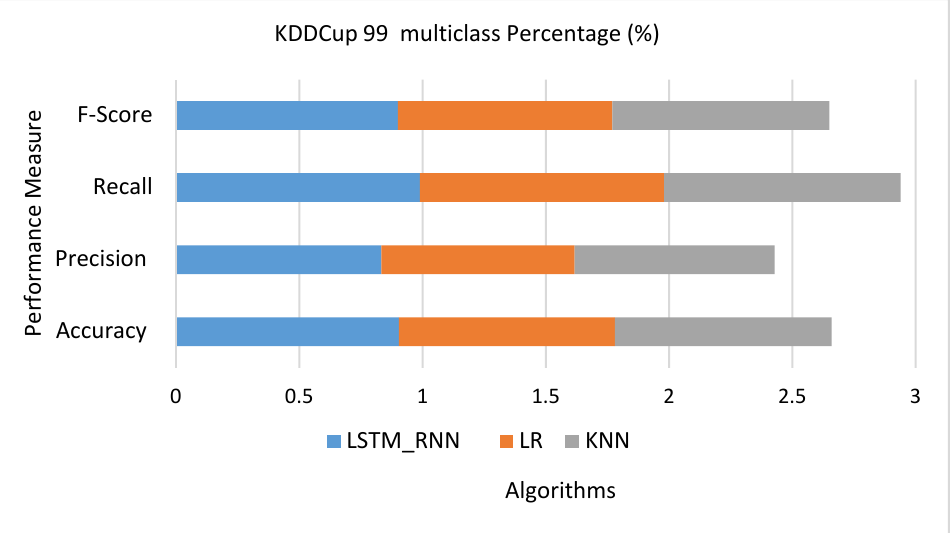
Figure 16. KDDCup 99 multiclass classification performance comparison.